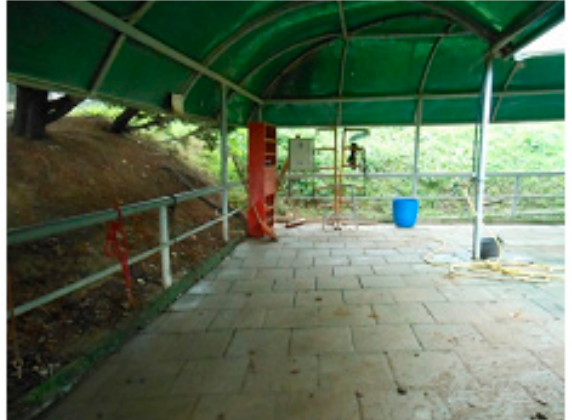
Figure 4. Area adjacent to the walker where the horses were cross tied and blood sampling, heart rate measurement, and infrared thermography technique (IRT) were performed. measurement, and infrared thermography technique (IRT) were